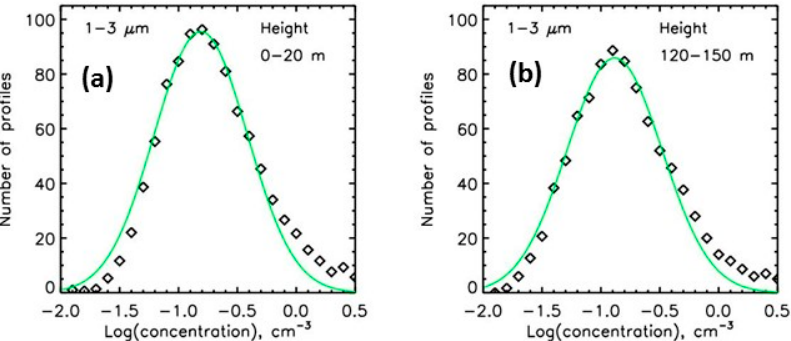
Figure 8. Examples of the histogram of the logarithm of the concentrations at two height ranges for the six years of measurements, for the 1 − 3 μ m size range. (a) measurements at ground; (b) measurements at the height of 120 − 150 m.